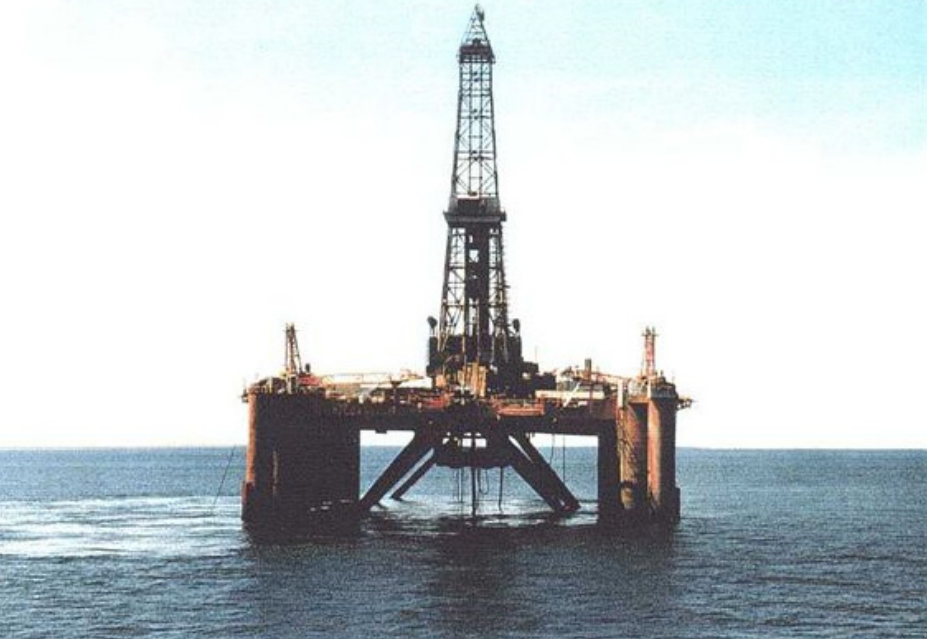
Figure 41. An offshore platform in the Andaman Sea, tilted by 3° during the passage of an internal wave. Much of the tilt is into the plane of the image.